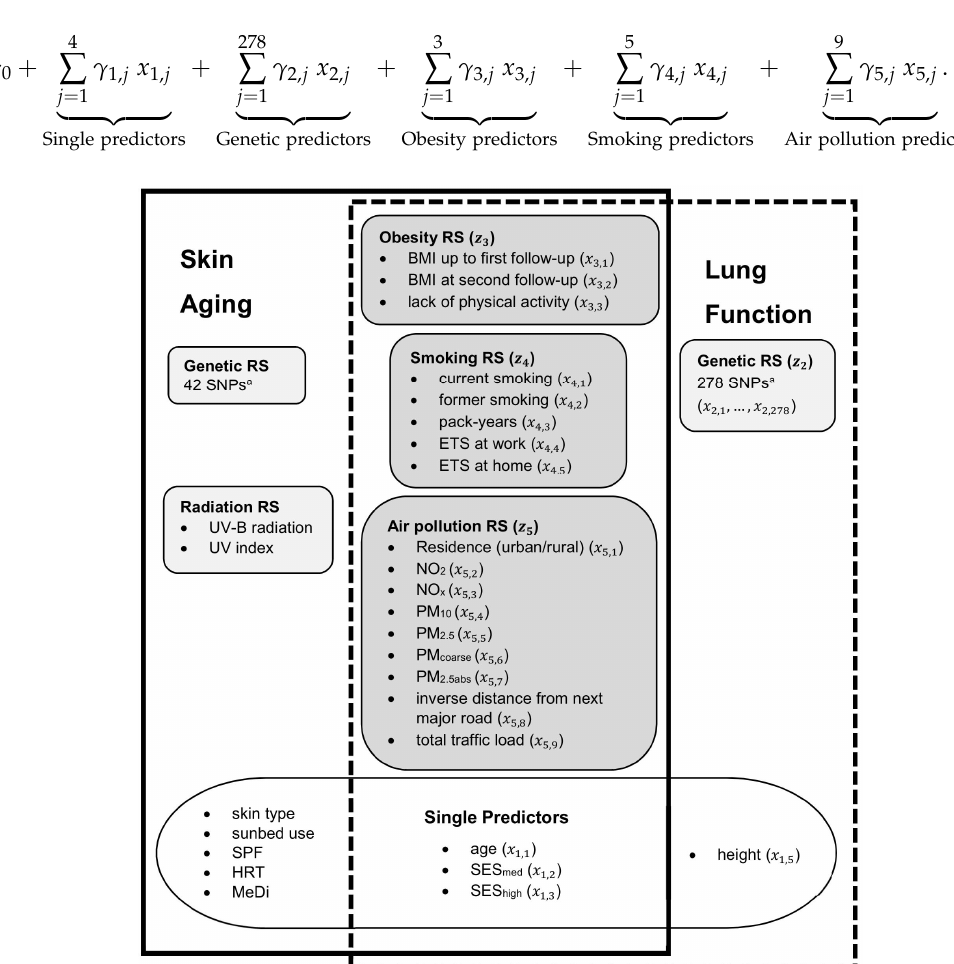
Figure 1. Overview of the risk scores and the combined predictors for both aging outcomes. The notation used in the description of the statistical approach is given in brackets, exemplary for lung function. BMI: body mass index; ETS: environmental tobacco smoke; HRT: hormone replacement therapy; MeDi: Mediterranean diet (definition: see Supplementary Materials); NO 2 : nitrogen dioxide; NO x : nitrogen oxides; PM 10 : particulate matter with aerodynamic diameter ≤ 10 µ m; PM 2.5 : particulate matter with aerodynamic diameter ≤ 2.5 µ m; PM coarse : coarse fraction of PM 10 calculated as PM 10 minus PM 2.5 ; PM 2.5abs : absorbance of particulate matter with aerodynamic diameter of ≤ 2.5 µ m; RS: risk score; SES: socio-economic status; SNP: single nucleotide polymorphism; SPF: sun protection factor; UV: ultraviolet. a Details on the selected SNPs are given in Supplementary Tables S2 and S3 (Supplementary File